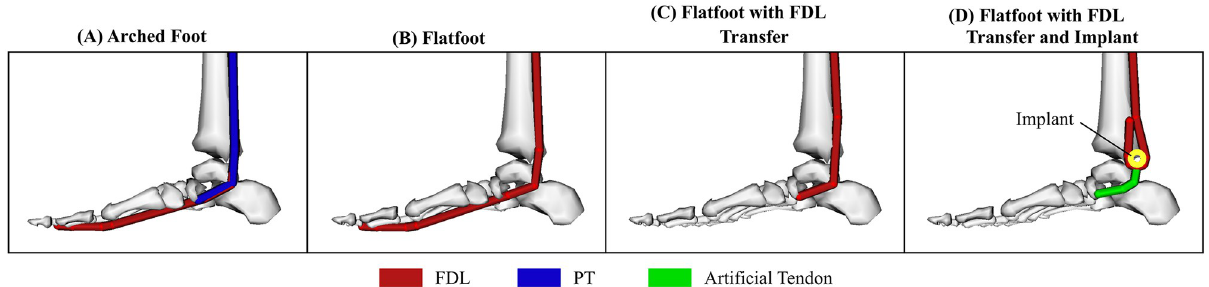
Fig 4. Overview of the four foot models. The stance phase of gait was simulated with forward dynamics using (A) an arched foot model, (B) a flatfoot model, (C) a flatfoot with FDL tendon transfer model, and (D) a flatfoot with FDL tendon transfer and implant model. Only the routing of the flexor digitorum longus (FDL) and posterior tibialis (PT) are shown for